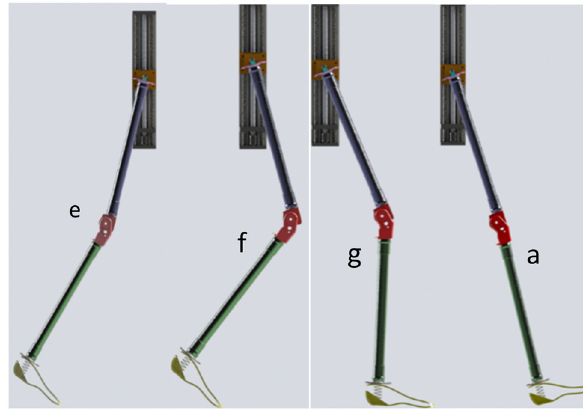
Figure 22: The swing phase of gait cycle: ( e ) pre - swing; ( f ) initial swing; ( g ) mid swing.